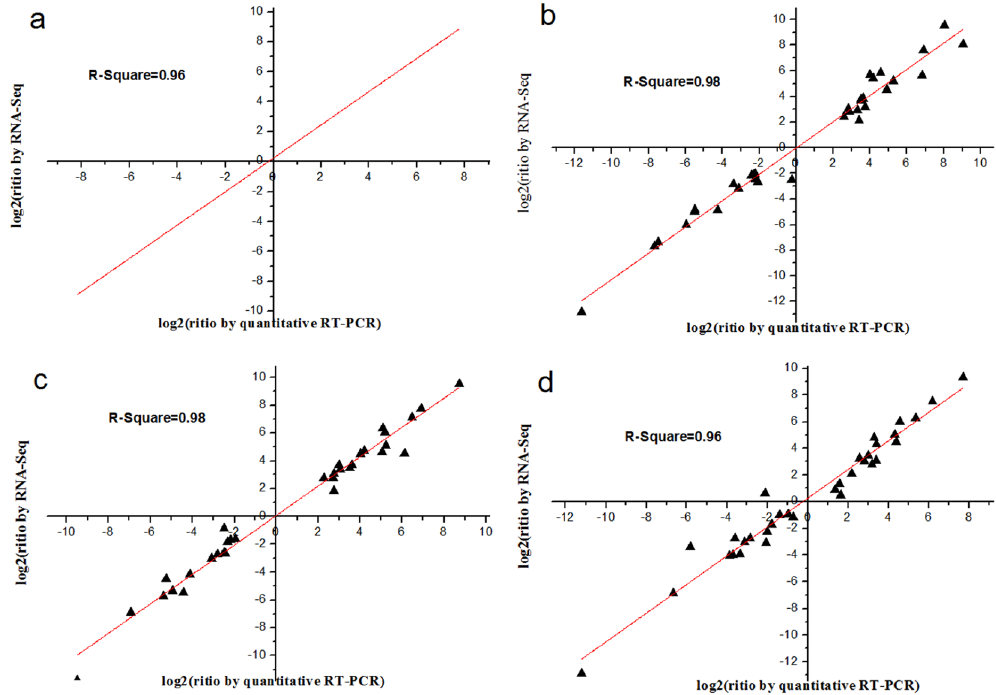
Figure 6. Comparison of expression profile by RNA-Seq and qRT-PCR. ( a – d ) Comparison of expression profile of 11 randomly selected DEGs by RNA-Seq and qRT-PCR at YZ1, R15, X33 and X42 (3h vs 0h, 3d vs 0h and 3d vs